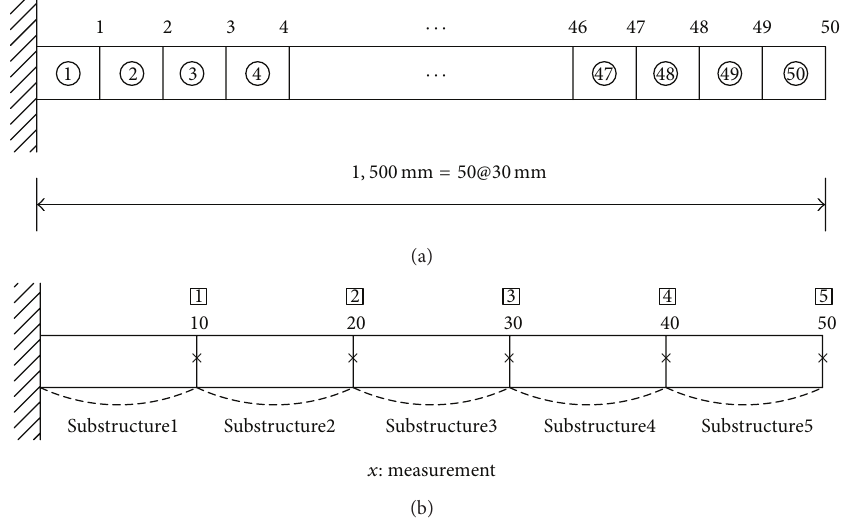
Figure 3: Substructuring of a cantilevered beam: (a) a cantilevered beam and (b) decomposition of a cantilevered beam.